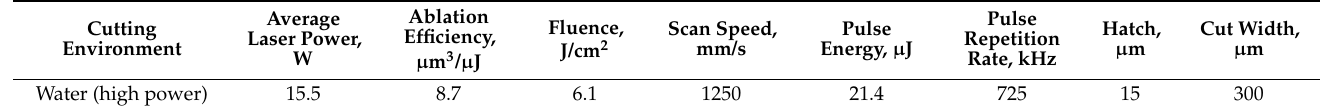
Table 4. Optimised glass cutting parameters. High-laser-power cutting in water.